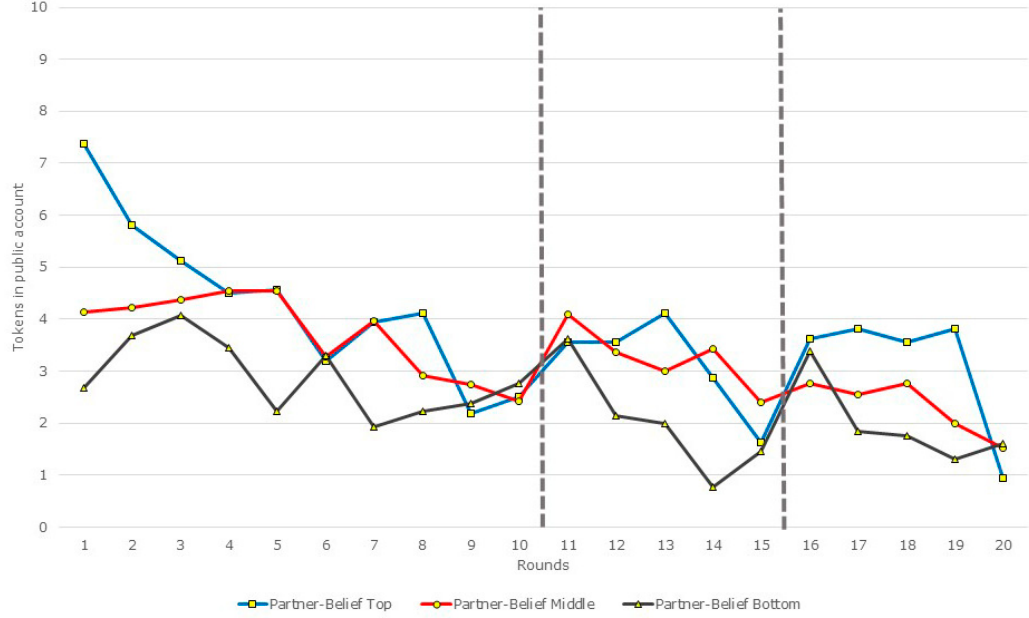
Figure 3. Overview of contributions by the three different belief types with partner matching.